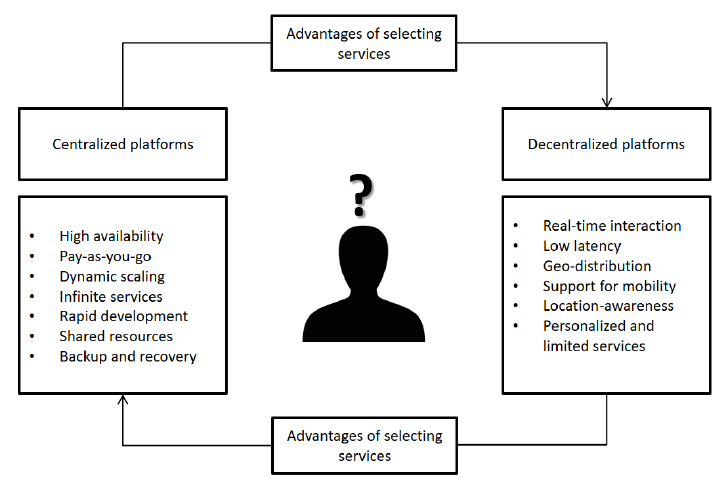
Figure 2. Advantages of selecting decentralized and centralized services.